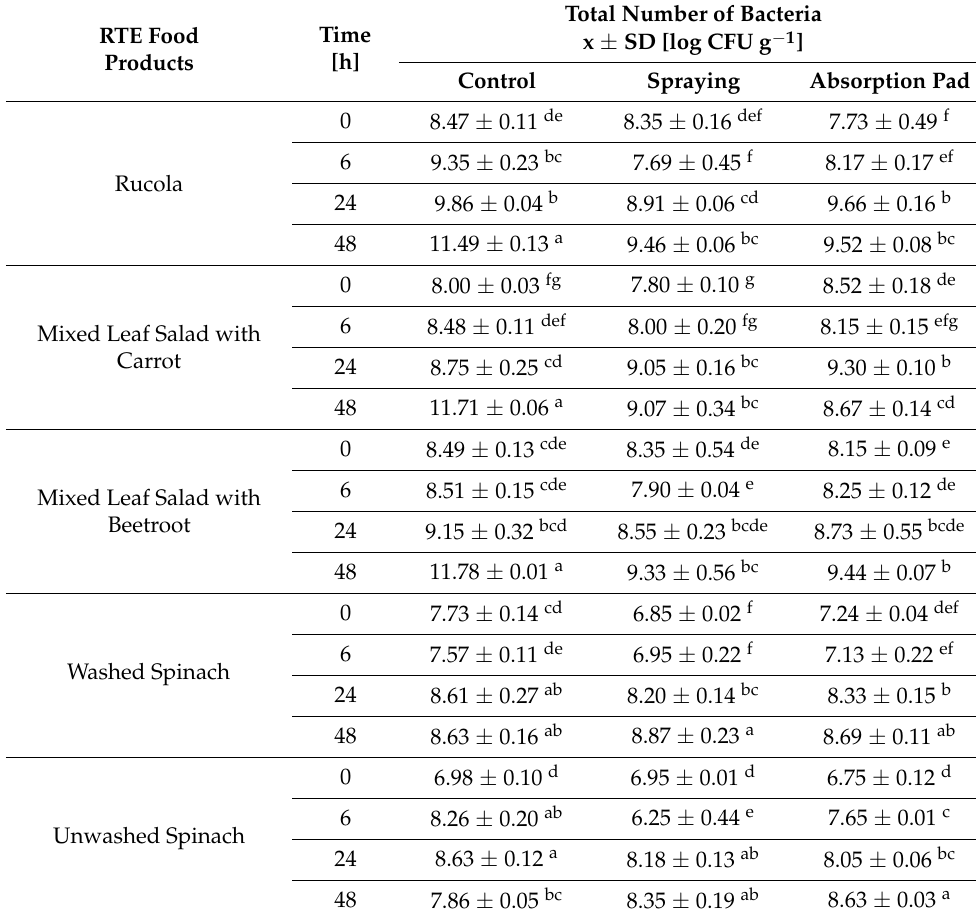
Table 6. The reduction level of the total number of bacteria (TNB) during storage after phage cocktail application. RTE Food